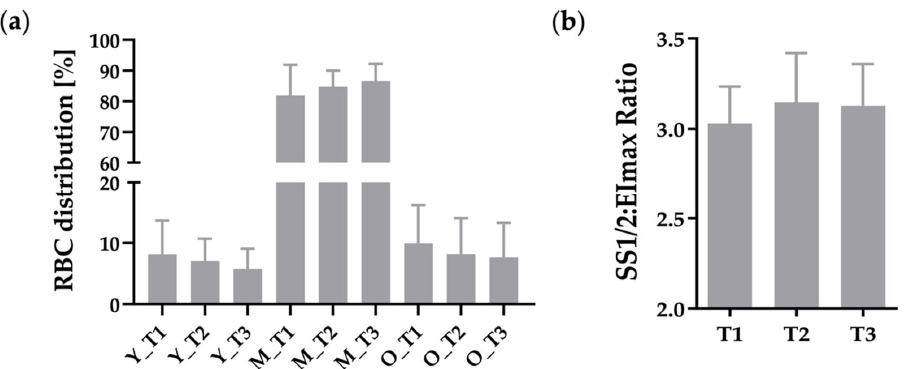
Figure 1. ( a ) Distribution of RBC subfractions in % with n = 11 at measured timepoints (T1, T2, and T3), indicating no significant changes due to hypoxia, Y = young RBC fraction, M = middle RBC fraction, O = old RBC fraction; ( b ) RBC deformability shown as SS 1/2 :EI max ratio, demonstrating no influence by hypoxia.